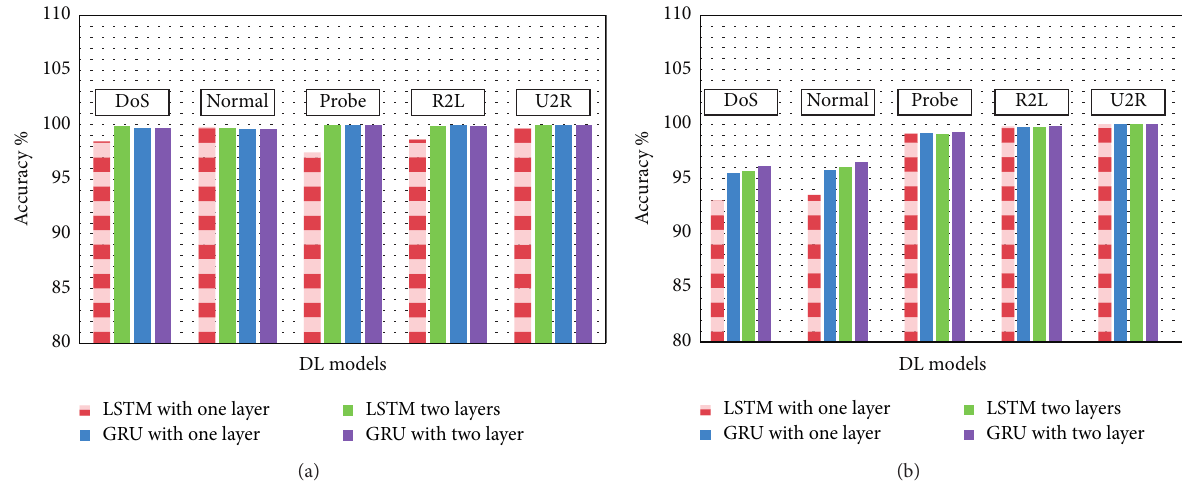
Figure 10: The results of deep learning testing performance for the KDD dataset: (a) accuracy using all features and (b) accuracy using selected